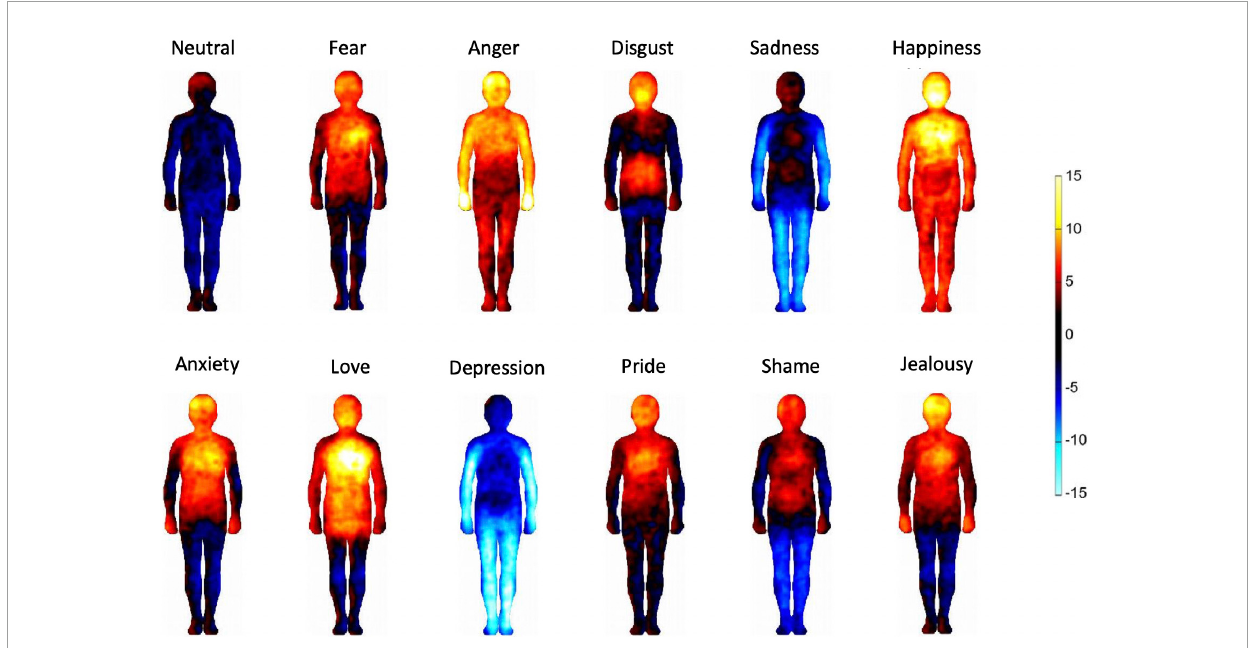
FIGURE3 Bodily maps of emotions. The bodily regions whose activation was increased are depicted by warm colors and the bodily regions whose deactivation was increased are depicted by cool colors. The color bar indicates the t -statistic